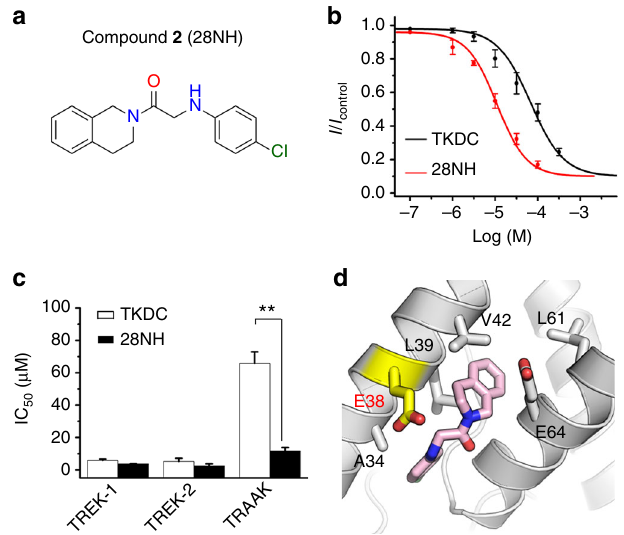
Fig. 4 Inhibition of TREK subfamily channels by 28NH in CHO cells.